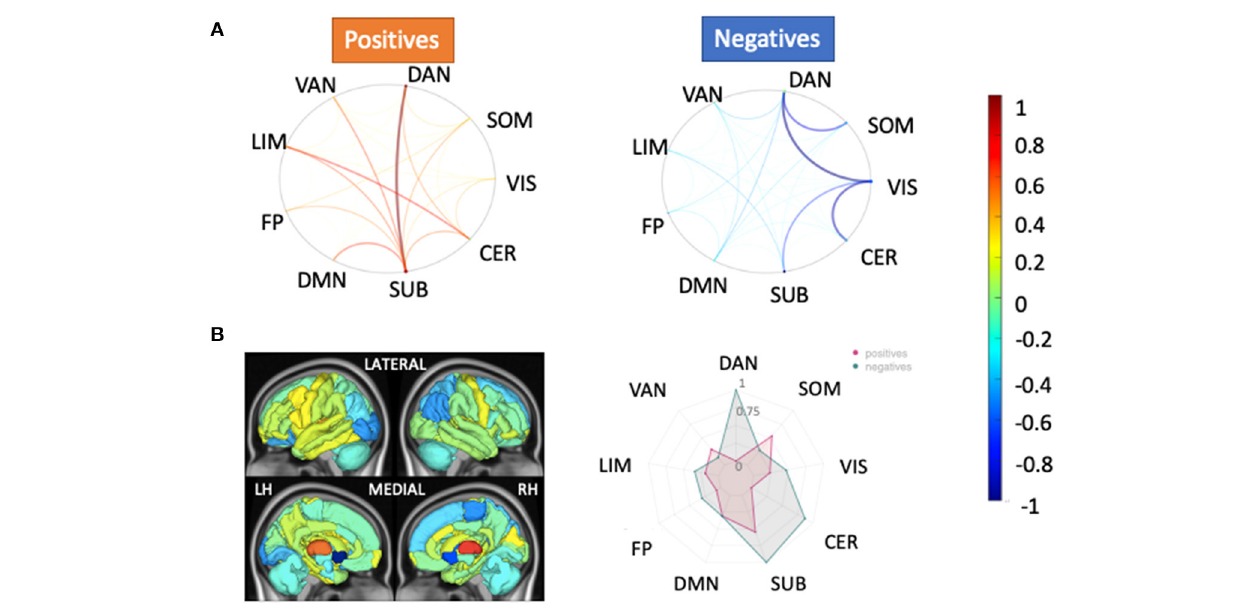
FIGURE 4 | Relative feature weights of the SC models for the HC vs. pwMS classification task. The relative feature weights (scaled by the maximum magnitude feature weight) for the variables used in the two models with the best classification performance in the HC vs. pwMS task: (A) pairwise SC and (B) regional SC (node strength). The circle plots in (A) illustrate the positive (hot colors) and negative (cool colors) model feature weights, respectively, for the pairwise SC model, averaged across the Yeo functional networks. The glass brain and radial plot figures in (B) show the relative feature weights from the regional SC (node strength) model, where the redial plot shows the positive and negative values averaged over the Yeo functional networks. Negative values (cooler colors) indicate those connections where larger values were associated with greater probability of being in the HC group while positive values (hotter colors) indicate those connections where larger values were associated with greater probability of being in the pwMS group. DAN, dorsal attention; VAN, ventral attention; LIM, limbic; FP, fronto-parietal; DMN, default-mode network; SUB, subcortex; CER, cerebellum; VIS, visual; SOM, somato-motor.